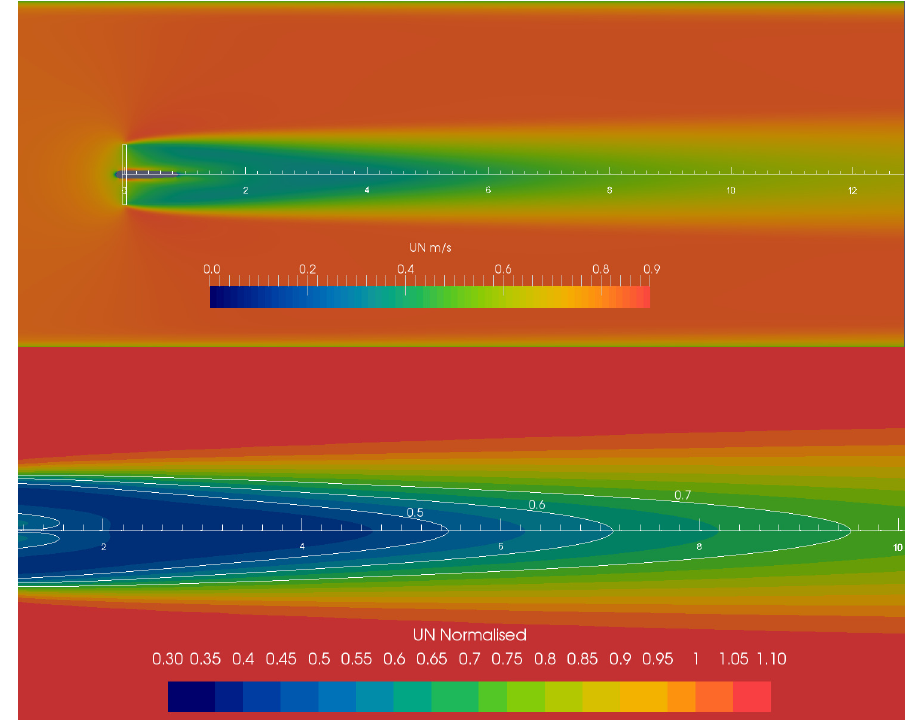
Figure 5. BEM-CFD model of IFREMER wake characteristics: axial velocity slice taken at the hub centre. Free stream velocity is 0.8 m · s − 1 ; TSR is 3.67; and background turbulence intensity is set at 3%. The top panel shows the full wake to the end of the domain, while the bottom panel is staged to compare with Figure 9a from [9] and includes isolines at 0.5, 0.6 and 0.7 normalised axial velocity.